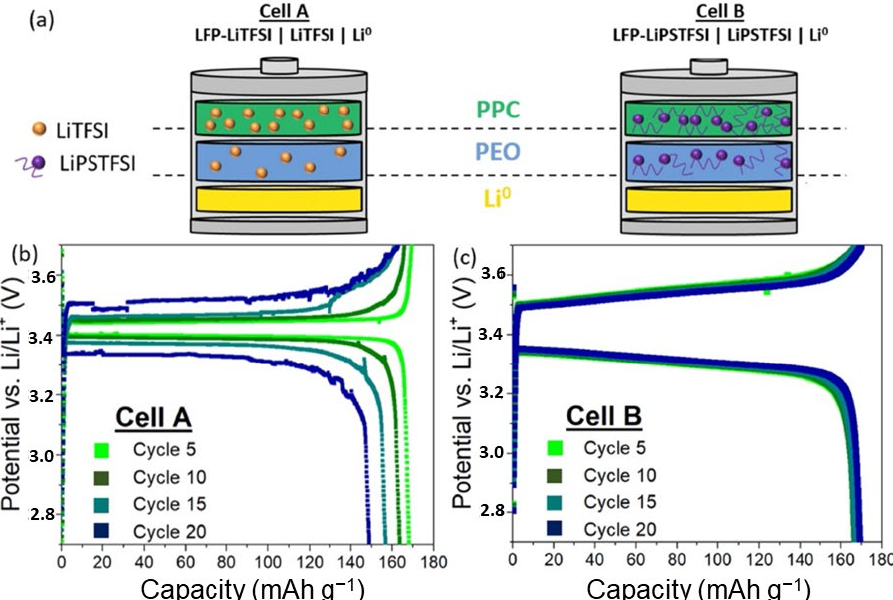
Figure 4. Proof-of-concept full cells of dual-layer polymer electrodes. Galvanostatic cycling of cells including different polymer-salt configurations described in ( a ). Schematics show Li conducting complexes LiTFSI (orange) and LiPSTFSI (purple), SPE PEO (blue), and catholyte PPC (green). Voltage profile upon cycling for the initial cycles at C/20 of ( b ) Cell A and ( c ) Cell B. Reproduced with permission from Ref. [58]. Copyright 2022 Elsevier.